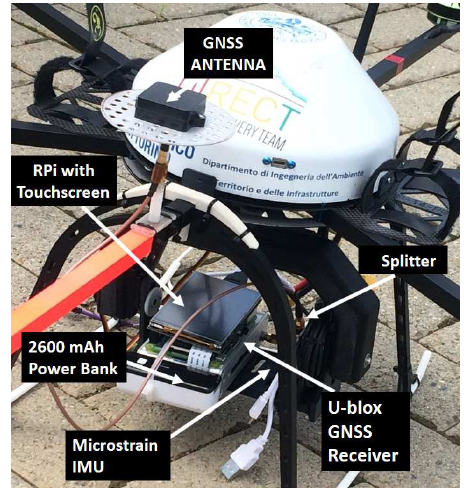
Figure 2. Photogrammetry System installed on UAV